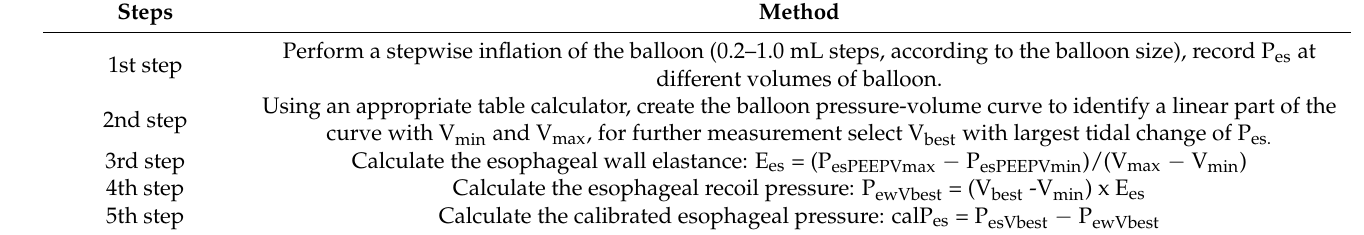
Table 2. Suggested steps to obtain a calibrated value of Pes. Adapted from Mojoli et al. [15] and Sun et al. [17].